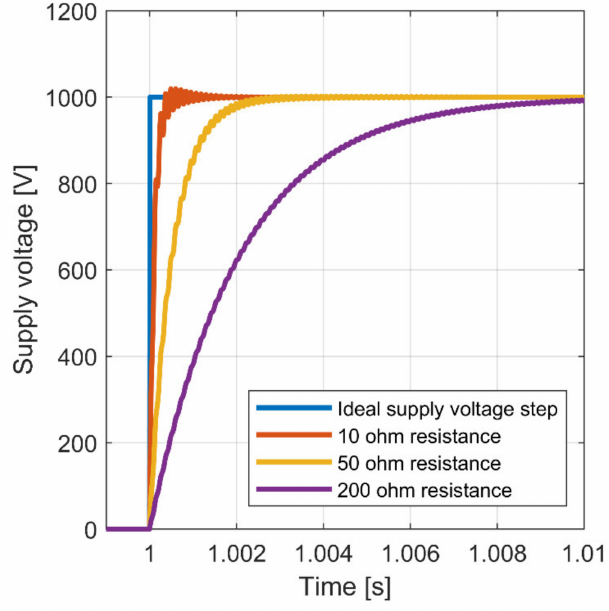
Figure 7. The 0–1000 V step response of the circuit with a piezo-stack actuator and different resistance values.